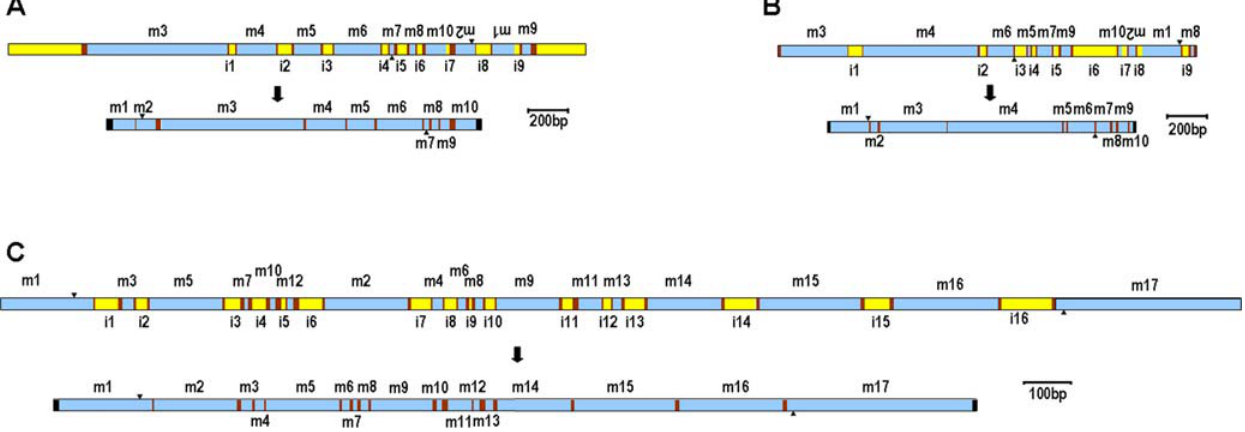
Figure 1. Schematic representation of the micronuclear precursor and resulting macronuclear gene structures (to scale) for (A) Stylonychialemnae (D strain) actinI , (B) OxytrichatrifallaxactinI , and (C) OxytrichatrifallaxTEBP a . MDSs represented in blue and labeled m (upside down if inverted); IESs (labeled i) and flanking DNA in yellow; pointer sequences, when shown, in maroon. Triangles mark the positions of start (pointing down) and stop codons (pointing up). Black boxes on both ends of the macronuclear structure represent telomeres.